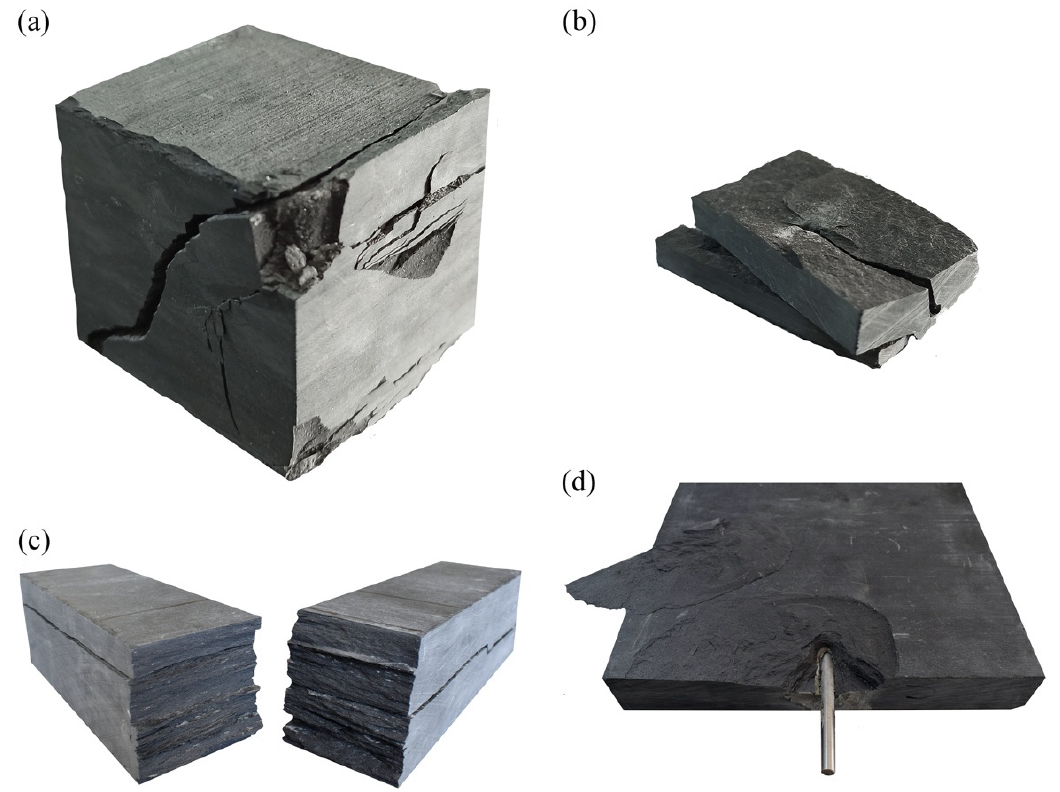
Figure 5. Results of aging test and mechanical characterization: ( a ) cubic slate, 50 mm side—rupture after uniaxial compression test; ( b ) prismatic specimens, 15 × 15 × 25 mm—rupture after the deter- mination of point load strength index; ( c ) prismatic slate specimens, 50 × 50 × 300 mm dimensions— rupture after flexure test; ( d ) slate specimens, 200 × 200 × 30 mm dimensions—rupture after the anchorage test.